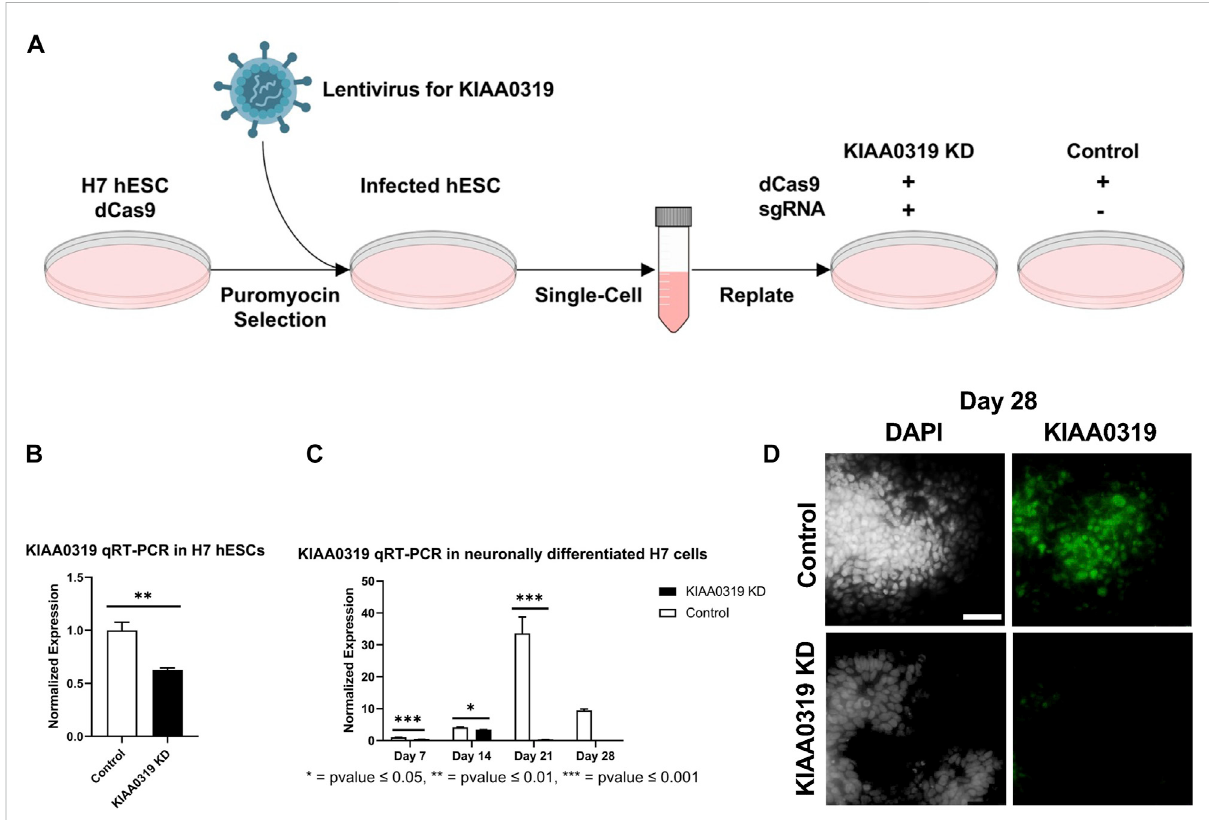
FIGURE 1 Depletion of KIAA0319 by CRISPR interference (CRISPRi) (A) Work fl ow for generating KIAA0319KD using CRISPRi in hESCs. (B) Con fi rmation of KIAA0319 KDbyqRT-PCRinH7cellsaftertransfectionandpuromycinselection. (C) Con fi rmationof KIAA0319 KDbyqRT-PCRondays7,14,21,and 28 of neuronal differentiation in H7 cells by qRT-PCR in neuronally differentiated H7 cells. (D) Immuno fl uorescence images of KIAA0319 KD and control on day 28. Green: KIAA0319, grey: DAPI. Scale bar: 50